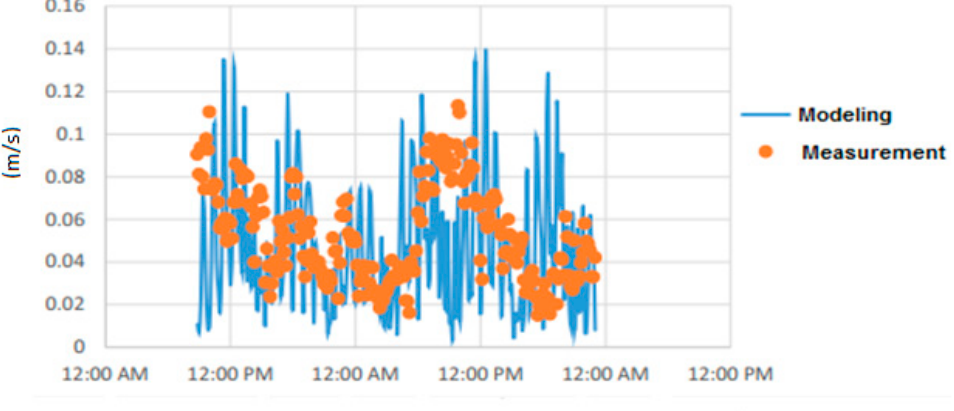
Figure 7. Delft3D modelled and measured current velocity.